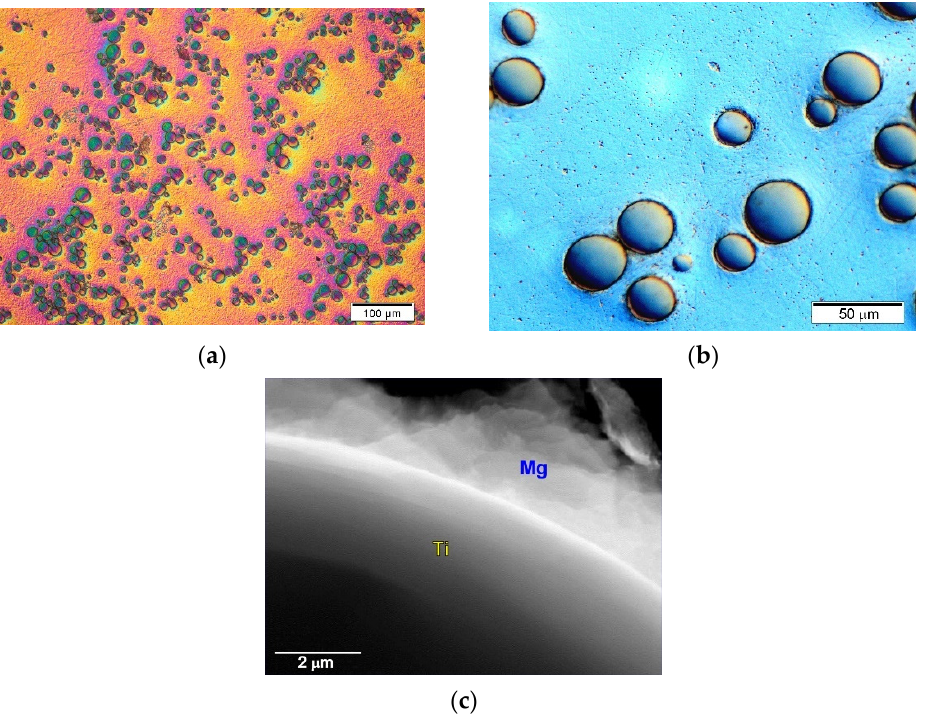
Figure 2. Microstructure of technically pure magnesium matrix composites with Ti particles. ( a , b ) Micrographs taken at different magnification; ( c ) TEM micrograph of interface between compo- nents.